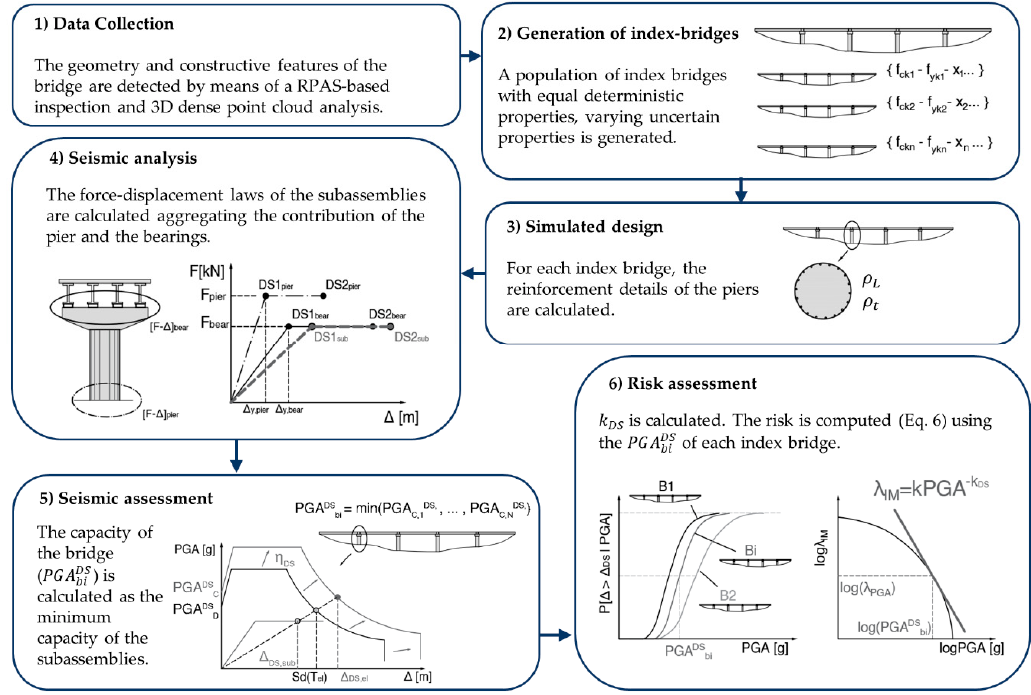
Figure 4. Flowchart of the proposed procedure for the seismic risk assessment of RC bridges.